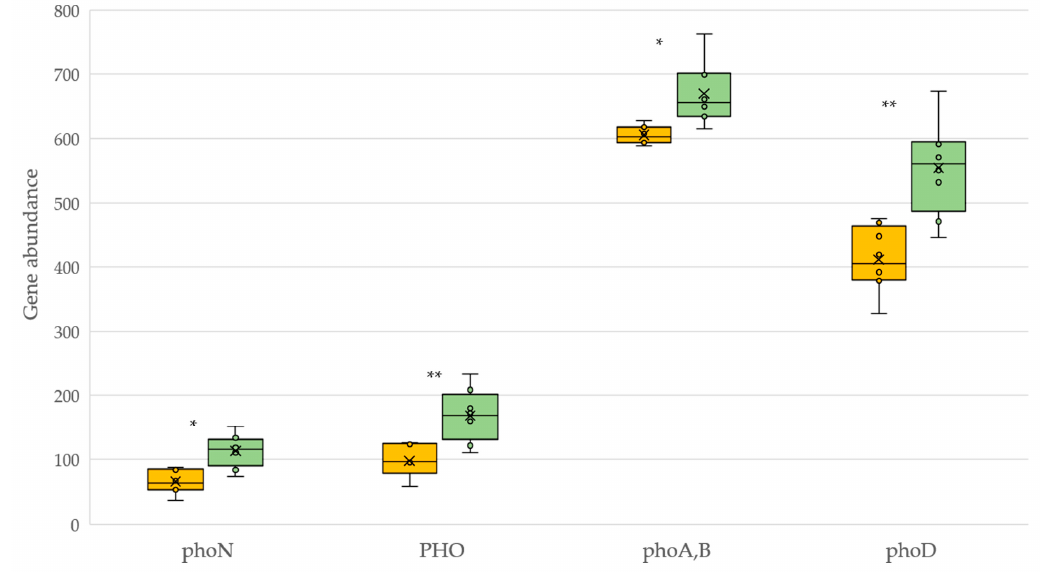
Figure 5. KEGG pathway molecular functions of organic phosphorus cycle for soils under conven-